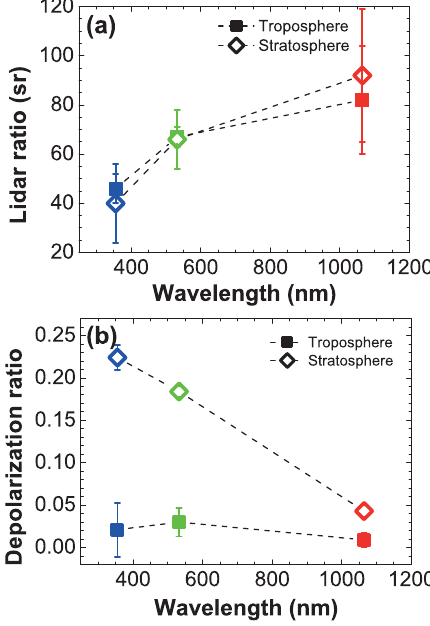
Figure 5. Comparison of the spectral dependence of the tropo- spheric (5–6km) and stratospheric (15–16km) particle lidar ratio (a) and particle linear depolarization ratio (b) . A strongly contrast- ing spectral behavior is found in the case of the depolarization ratio and an almost similar wavelength dependence (in the troposphere and stratosphere) is found for the lidar ratio. Only BERTHA values are